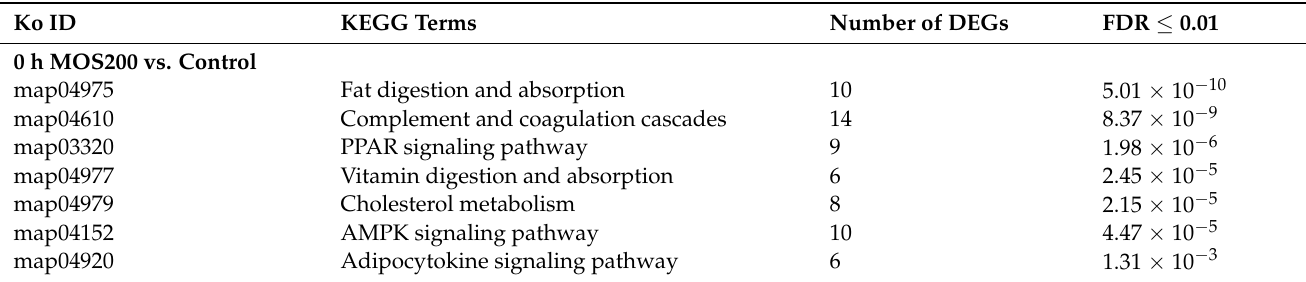
Figure 3. The 30 mainly enriched Kyoto Encyclopedia of Genes and Genomes (KEGG) terms of identified DEGs. I: cellular processes, II: environmental information processing, III: genetic information processing, IV: metabolism, V: organismal systems. ( A – C ) was KEGG enrichment of DEGs between MOS200 and control groups at 0, 4 and 24 hpi, respectively. ( D – F ) was KEGG enrichment of DEGs between MOS400 and control groups at 0, 4 and 24 hpi, respectively. Table 3. The top 10 enriched Kyoto Encyclopedia of Genes and Genomes (KEGG) pathways of identified differentially expressed genes (DEGs) at different time points